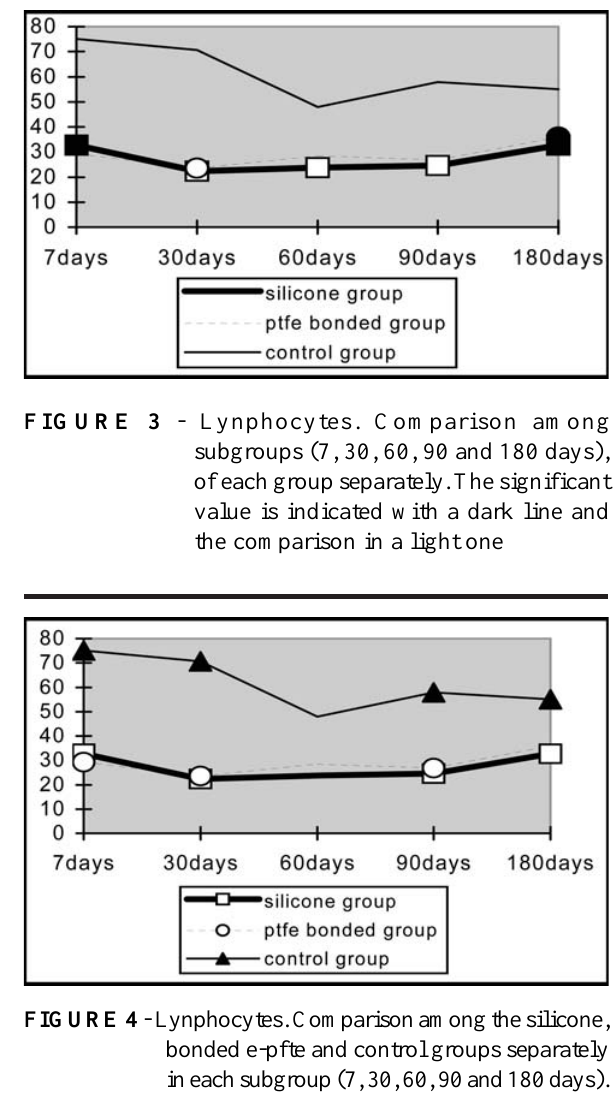
number of macrophages in the silicone and bonded e- ptfe groups compared to the control group (p<0.01).